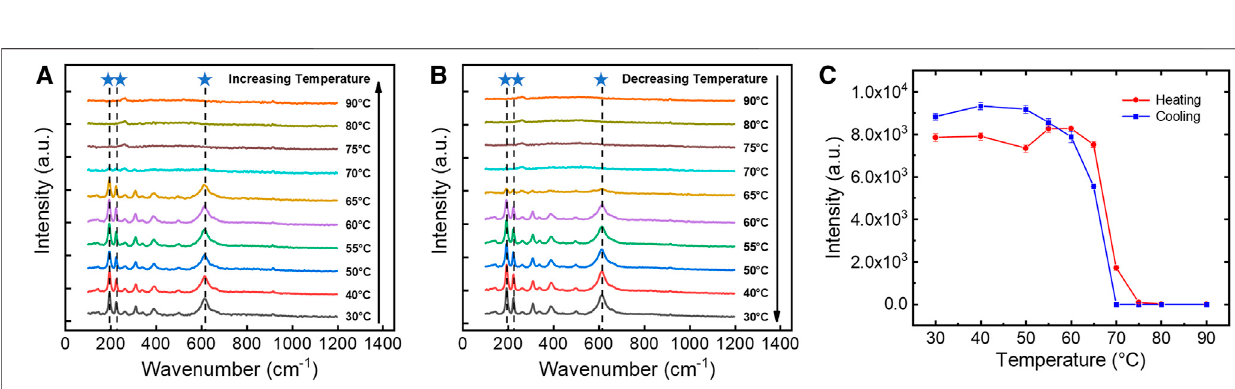
FIGURE 6 | Raman spectra of the (A) heating process and (B) cooling process of VO 2 /Al 2 O 3 epitaxial fi lms. The stars in the fi gure represent Ag modes in the VO 2 fi lm. (C) The relative integrated intensity of the Raman characteristic peak of the Ag mode located at 194 cm − 1 as a function of temperature. The error bars are propagated from the calculated integrated